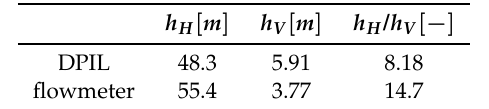
Table 1. Distances where the rank correlation is zero (range) in the vertical ( h V ) and horizontal ( h H ) direction and the anisotropy ratio ( h H / h V